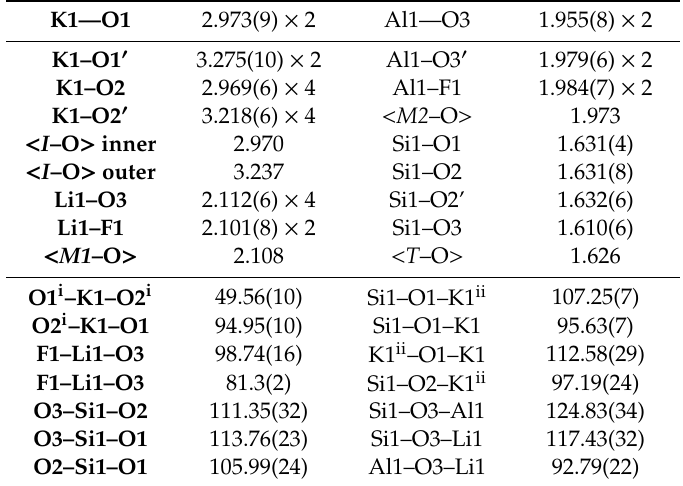
Table 6. Selected bond lengths (Å) and angles ( ◦ ) for